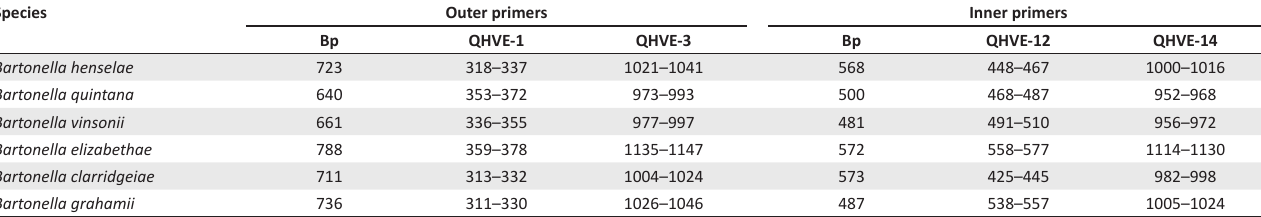
TABLE 2: Primer binding localities and product sizes of the six most commonly isolated human Bartonella